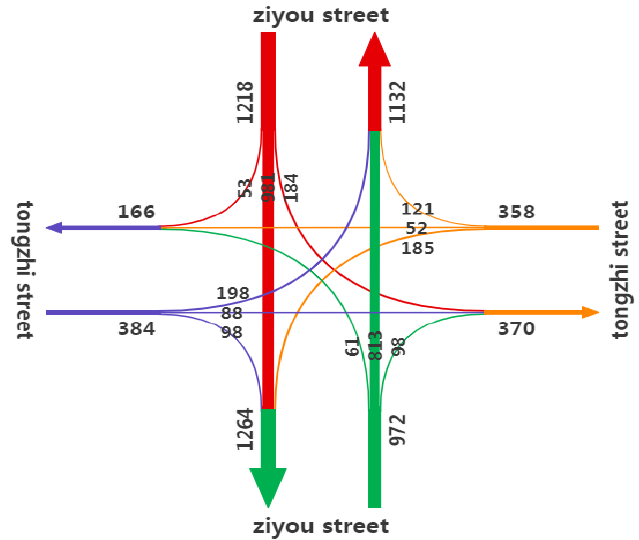
Figure 8. Test intersection traffic flow.